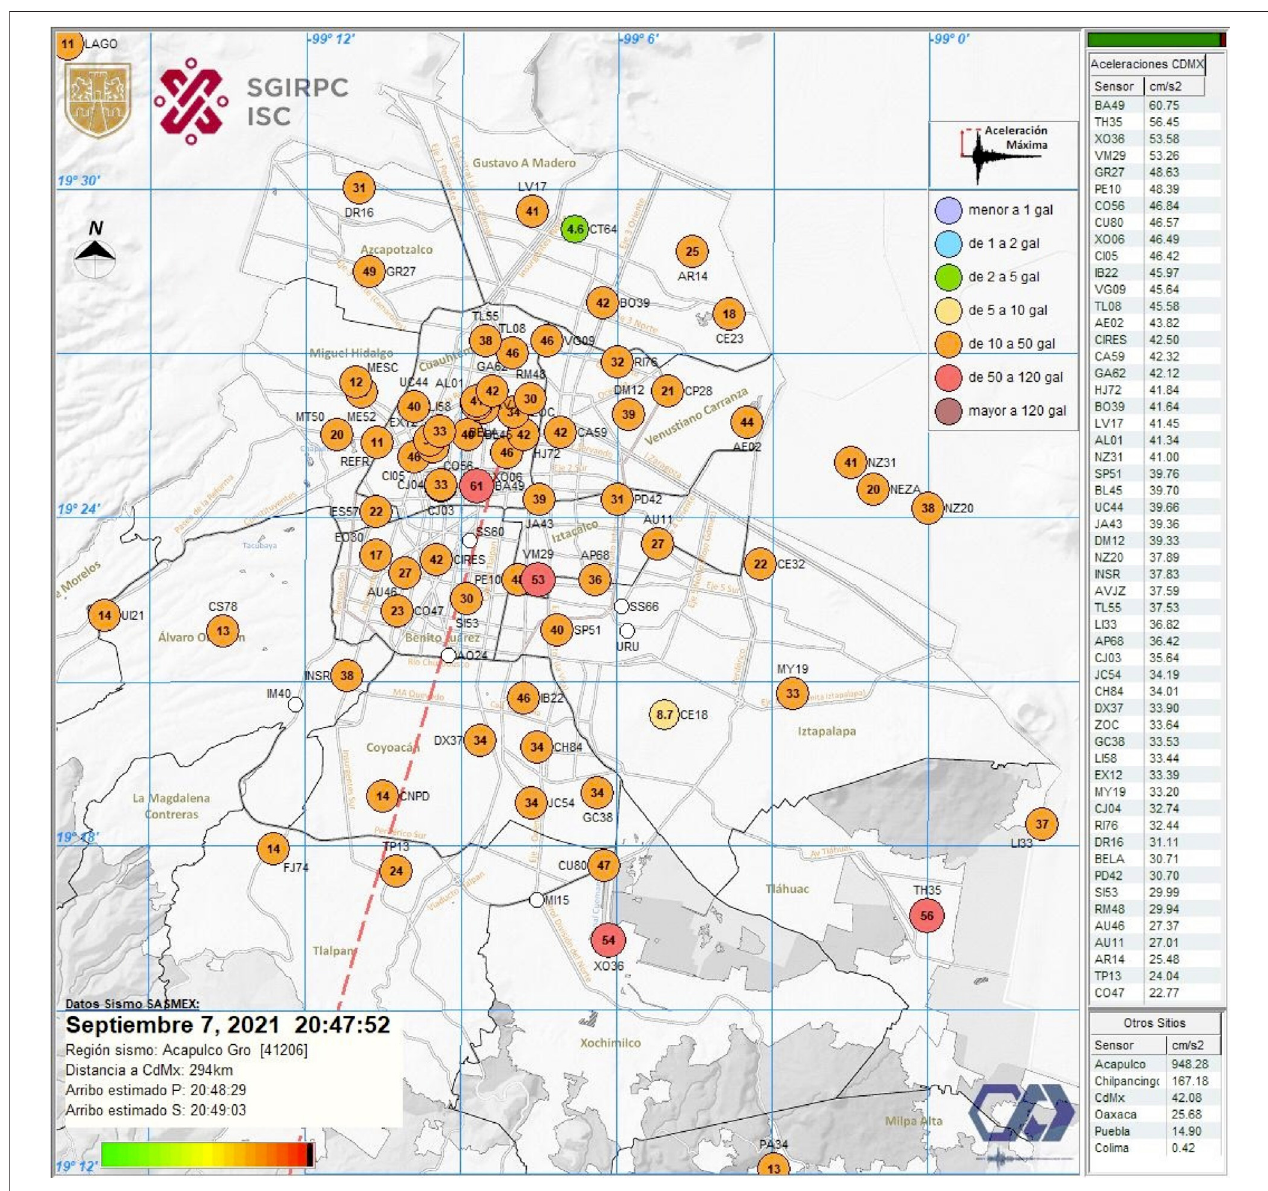
FIGURE 3 | Example of map sent via WhatsApp, Telegram, and internet messaging showing the observed peak ground acceleration in stations of the strong motionnetworkofMexico City forthe 7September 2021Acapulcoearthquake(Mw 7.2).Thesemaps aresent toauthorizedusers about 1 minute after the arrival ofthe strong ground motion in